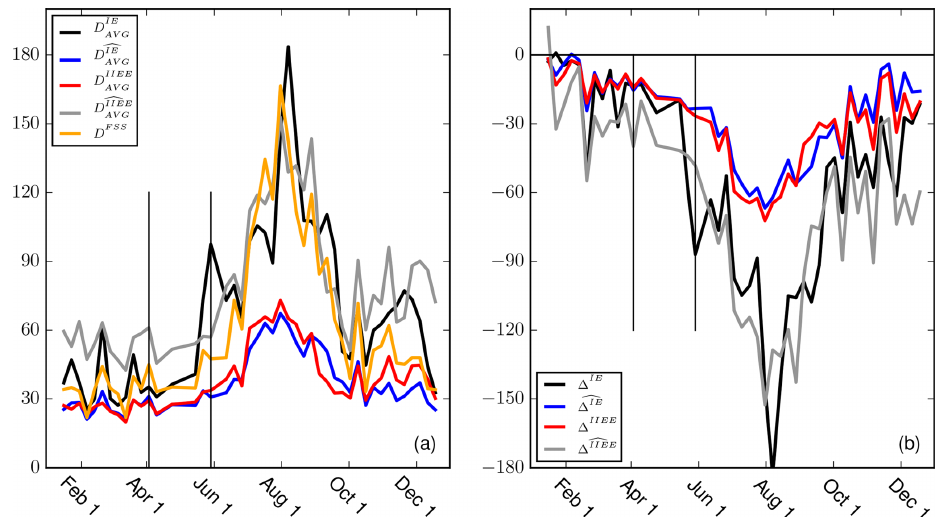
Figure 6. Time series for (a) mean displacement and (b) bias metrics as defined in Sect. 2. All results are for the 5d forecasts. Vertical lines correspond to the two forecasts that were analysed in Sect. 4. Values along the vertical axes are in units of kilometres.